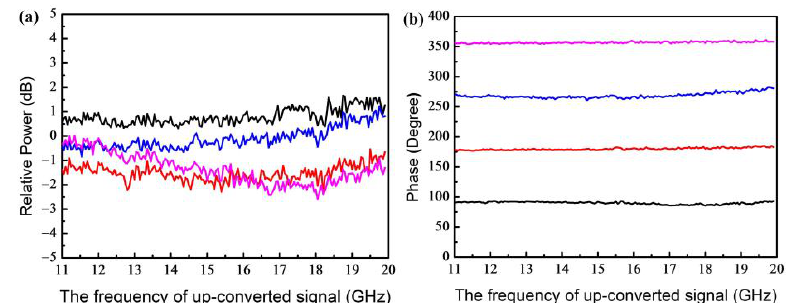
Figure 8. Measured ( a ) power response and ( b ) phase response of the microwave photonic mixer working in the up-conversion mode, where the IF signals in the range of 1 GHz to 9.9 GHz are up-converted to the range of 11 GHz to 19.9 GHz by using an LO signal at 10 GHz.